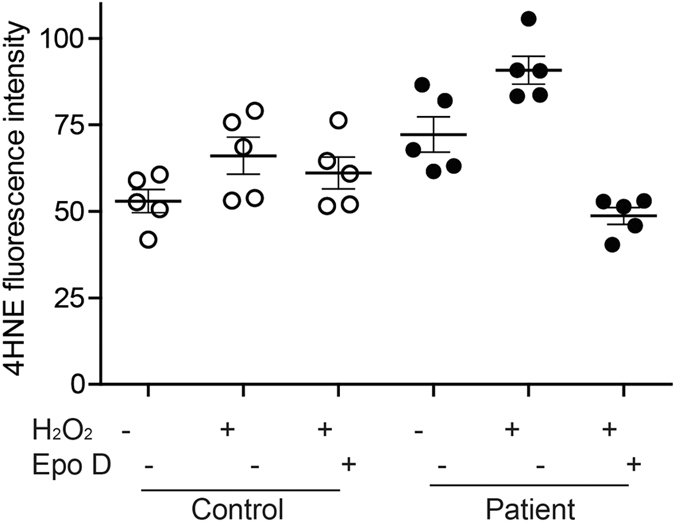
Epothilone D ameliorated hydrogen peroxide-induced oxidative stress in patient cells.4HNE fluorescence in cells (control and patient) cultured under normal culture conditions; exposed to H2O2 and treated with 2 nM epothilone D for 7 days and then exposed to H2O2. N = 1204 control cells under normal culture conditions; 1402 control cells exposed to H2O2; 1066 control cells treated with epothilone D and exposed to H2O2; 1178 patient cells under normal culture conditions; 1209 patient cells exposed to H2O2 and 1013 patient cells treated with epothilone D and exposed to H2O2. The fluorescence intensity was significantly different among the groups (repeated measures ANOVA; control v/s patient: p = 0.024; main effect of treatment (both H2O2 and epothilone D): p = 0.008; disease status and treatment: p = 0.007).